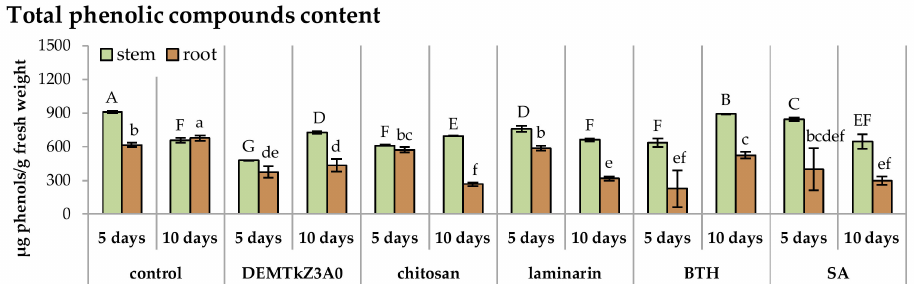
Figure 16. Total phenolic compounds content stem and root of wheat seedlings after 5 and 10 days inoculation with Trichoderma DEMTkZ3A0 strain and potential inducers (commercial elicitors) of plant resistance: chitosan, laminarin, BTH and